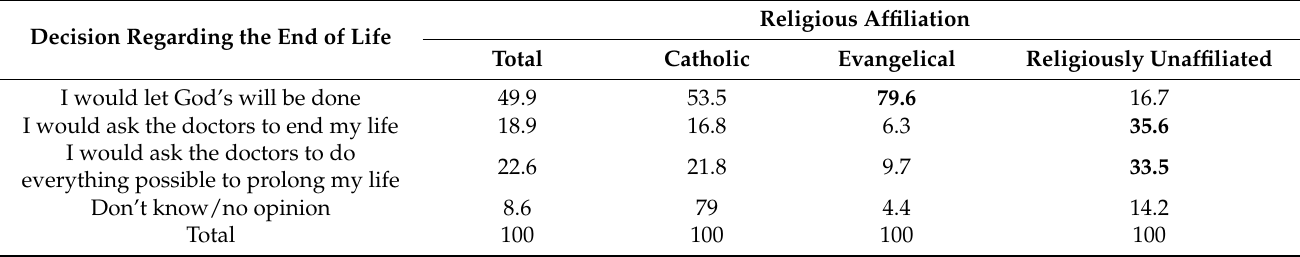
Table 4. Personal decision regarding the end of life according to religious affiliation (in %).